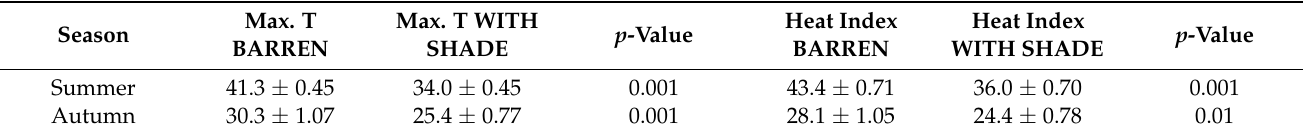
Table 1. Differences between maximum temperature (°C) and heat index (°C) in summer and au- tumn in the direct sunlight (BARREN) and in the shaded area (WITH SHADE) (mean ± SE) in Santa Catarina, Brazil.